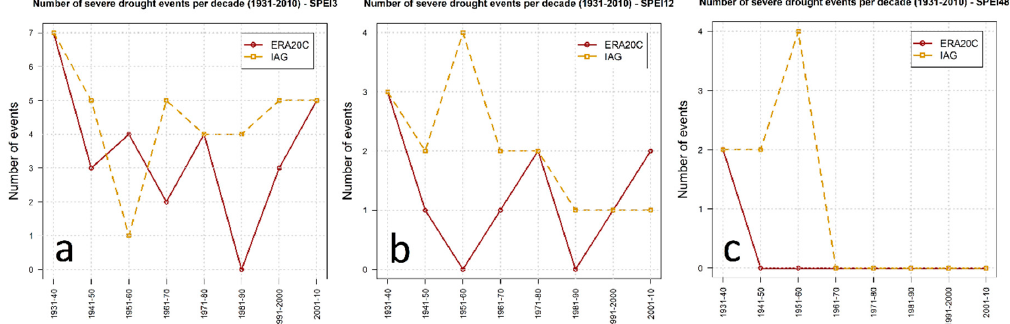
Figure 4. Time series of severe drought events per decade in Sao Paulo state, for ( a ) 3-, ( b ) 12- and ( c ) 48-month SPEI. The red solid line represents events obtained from ERA20C reanalysis and the dashed yellow line represents events from the observed data (IAG weather station).